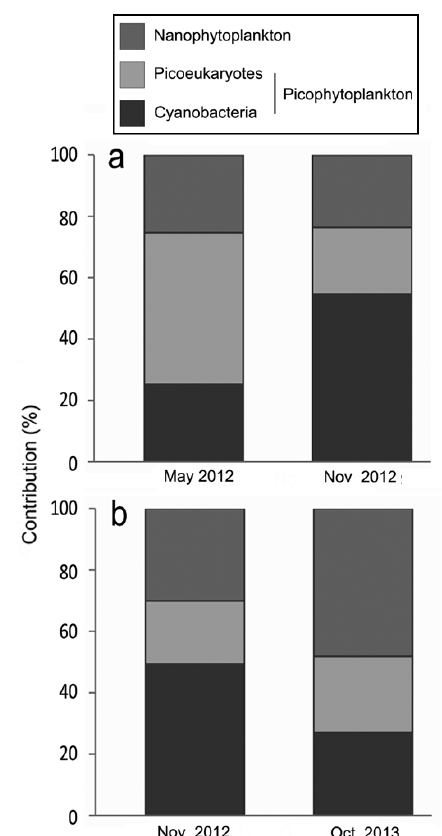
Fig. 6. Proportion of carbon retained by (a) Didemnum sp. and (b) Herdmania momus according to the different groups of phytoplankton for each sampling